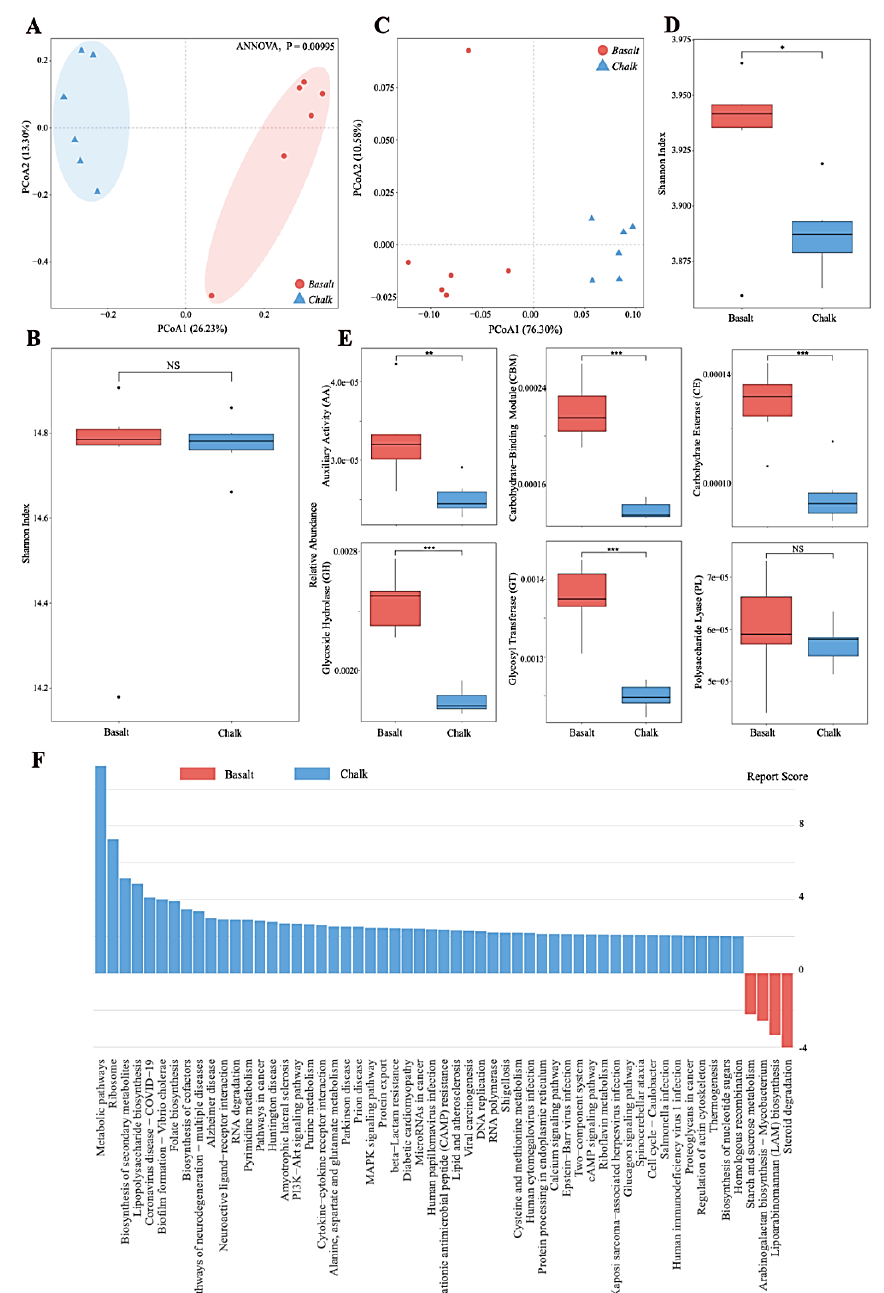
Figure 3. Functional composition of the two soil type metagenomics. ( A ) Principal component analysis shows the function composition of the two soil types was clearly separated. ( B ) There was no significant difference based on the Shannon index of non-redundant gene sets. ( C ) Principal component analysis shows that the comparison of carbohydrate-active enzymes (CAZyomes) composition of the two soil types was clearly separated. ( D ) The diversity of CAZYomes in basalt is higher. ( E ) Comparison of abundances of different CAZYomes families between basalt and chalk. ( F ) KEGG pathways with significant differences between basalt and chalk. In this figure, *, **, and *** indicates the significance levels p < 0.05, p < 0.01, and p < 0.001; and NS indicates not significant accordingly.